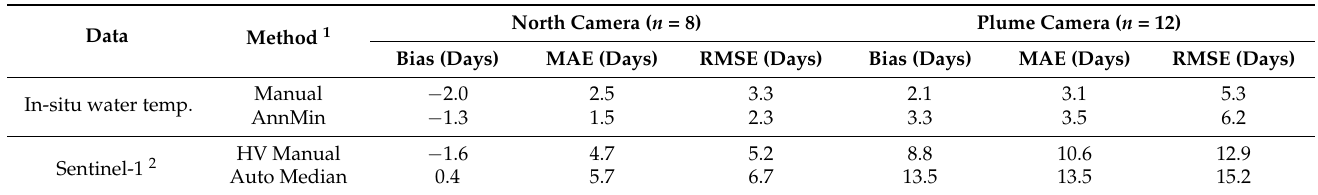
Table 2. Agreement between FUE dates from the camera images and other FUE estimation